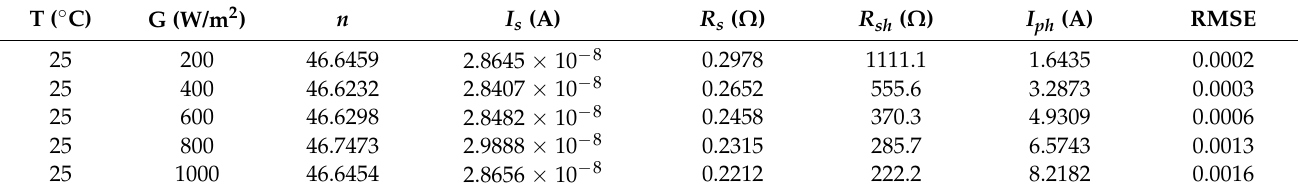
Table 3. Parameter-extraction results and RMSE for I- and P-V Curves in Figures 9 and 10.